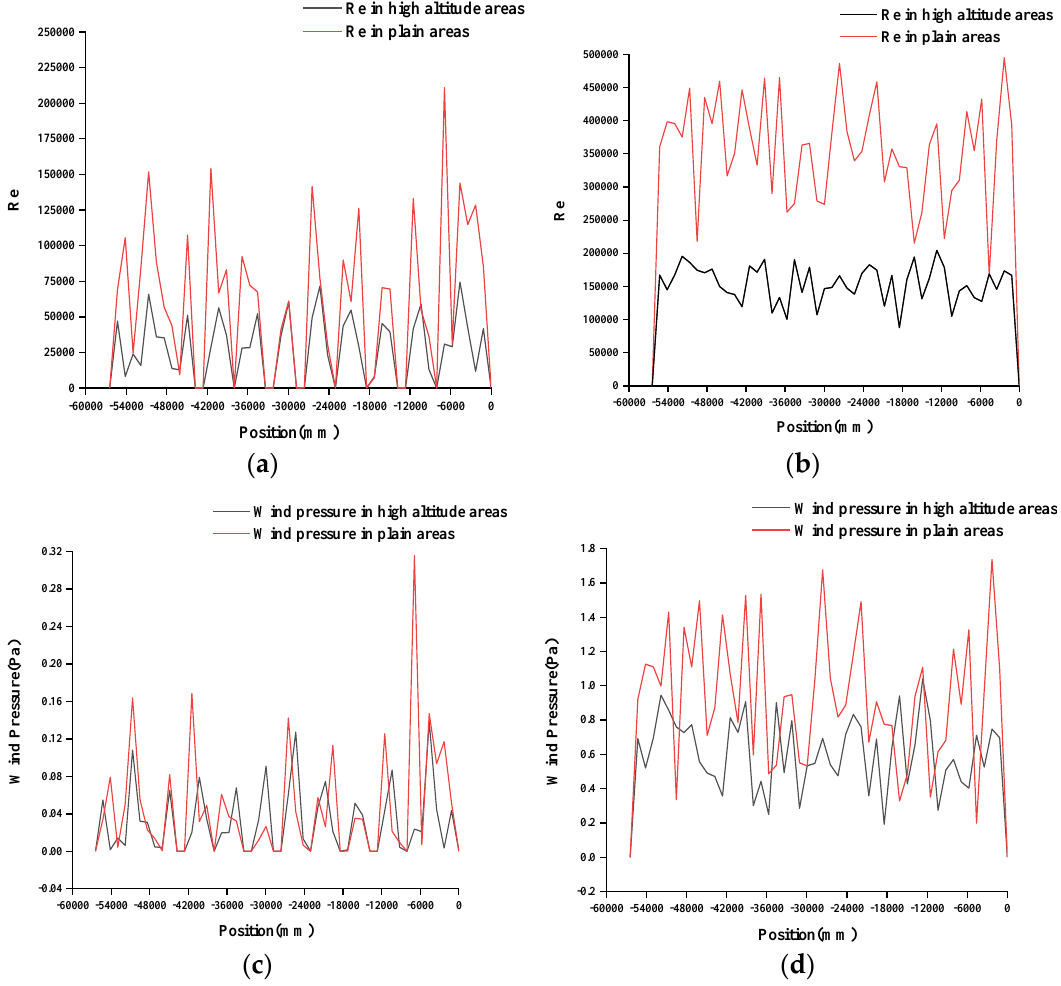
Figure 10. Variation in wind pressure characteristic parameters in high − altitude and plain areas of: ( a ) x = 4000 mm, Re; ( b ) x = 600 mm, Re; ( c ) x = 4000 mm, wind pressure; ( d ) x = 600 mm, wind pressure.